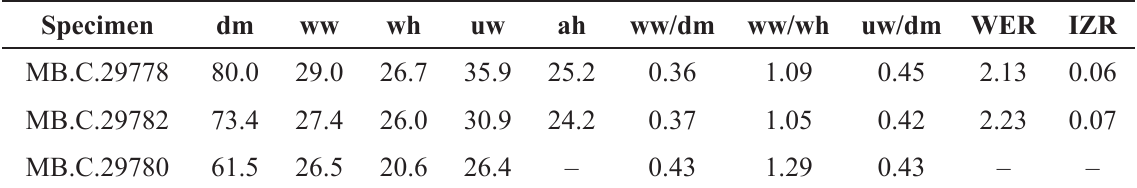
Table 11. Conch dimensions (partly estimated) and ratios of selected specimens of Paratirolites robustus Korn & Hairapetian sp. nov. from Baghuk